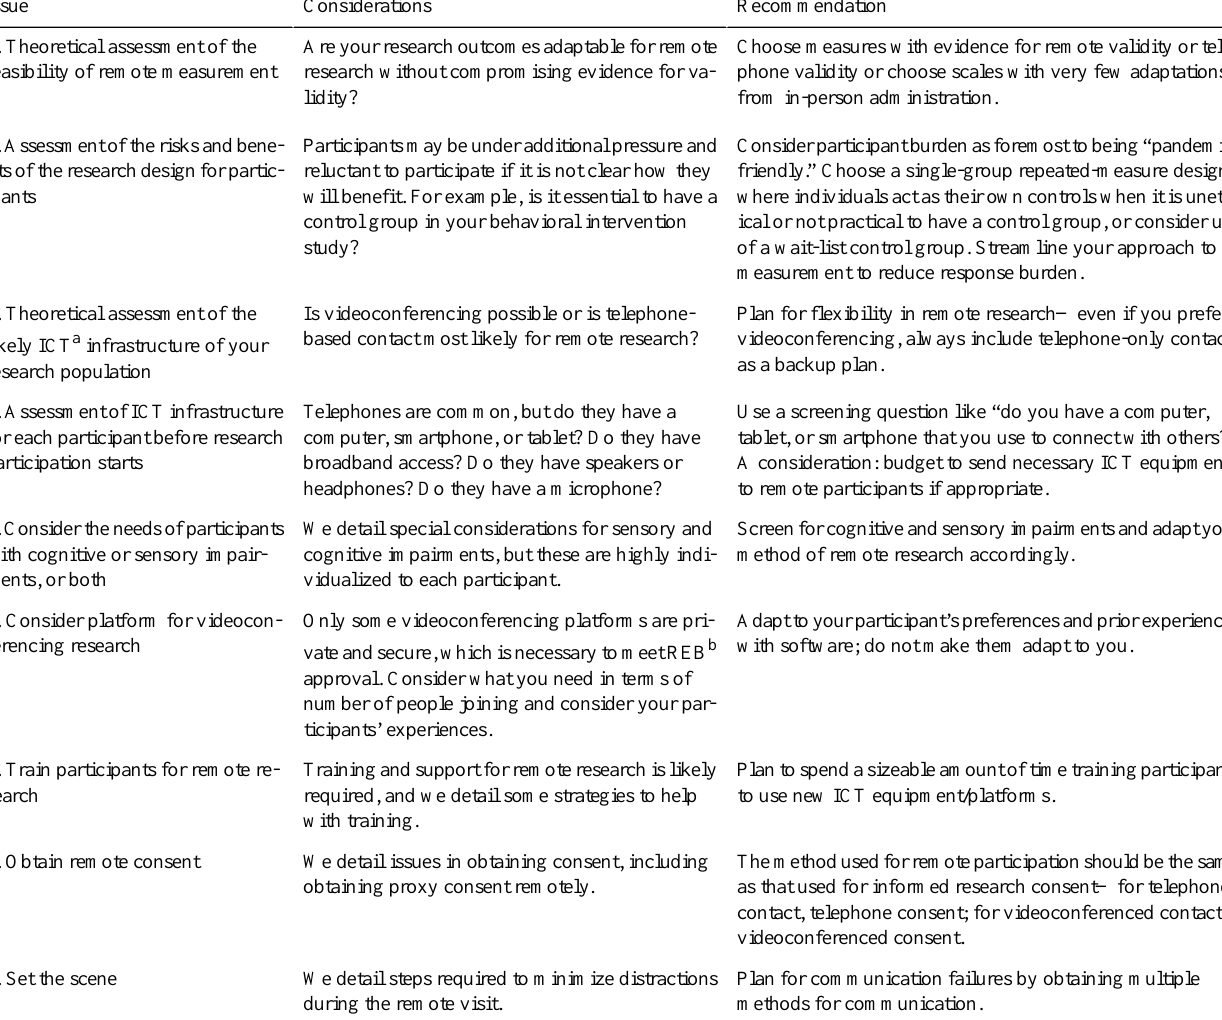
Table 1. Zero to 100 in remote dementia research